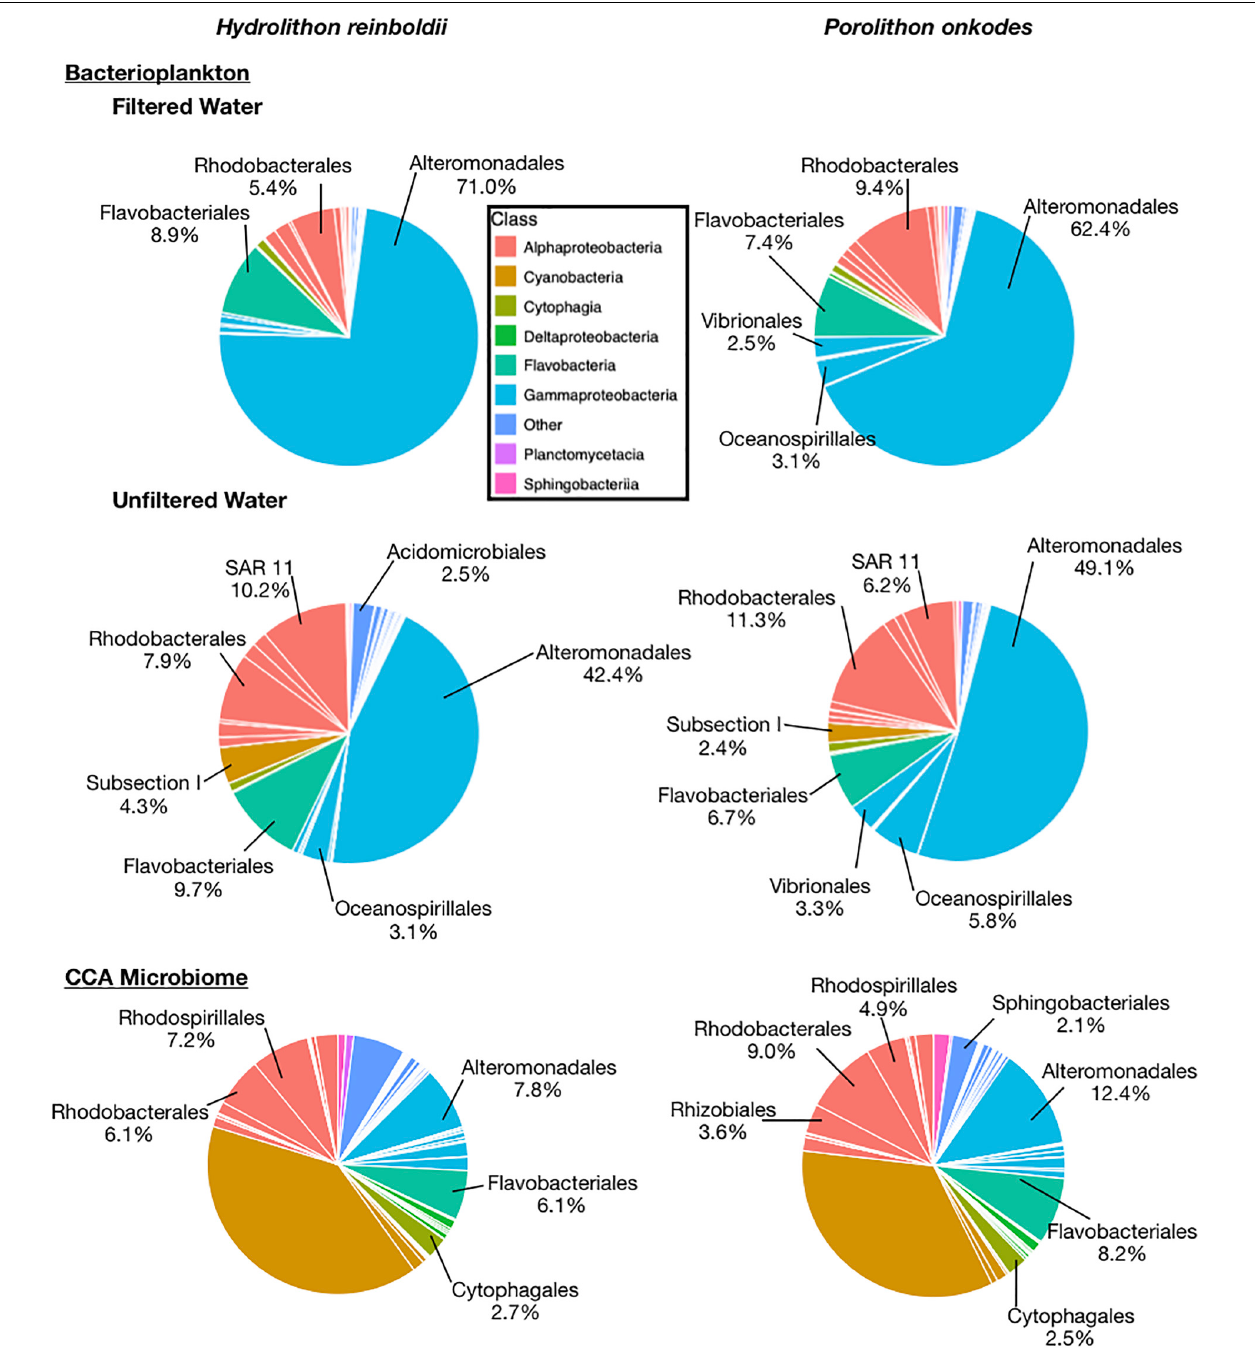
FIGURE 3 | Relative abundances of microbial orders found with Hydrolithon reinboldii and Porolithon onkodes. Mean relative abundances were calculated from replicate plants, n = 3. Pie wedges represent orders and color fill represents class. Orders that could be classified and had relative abundances greater than 2% are